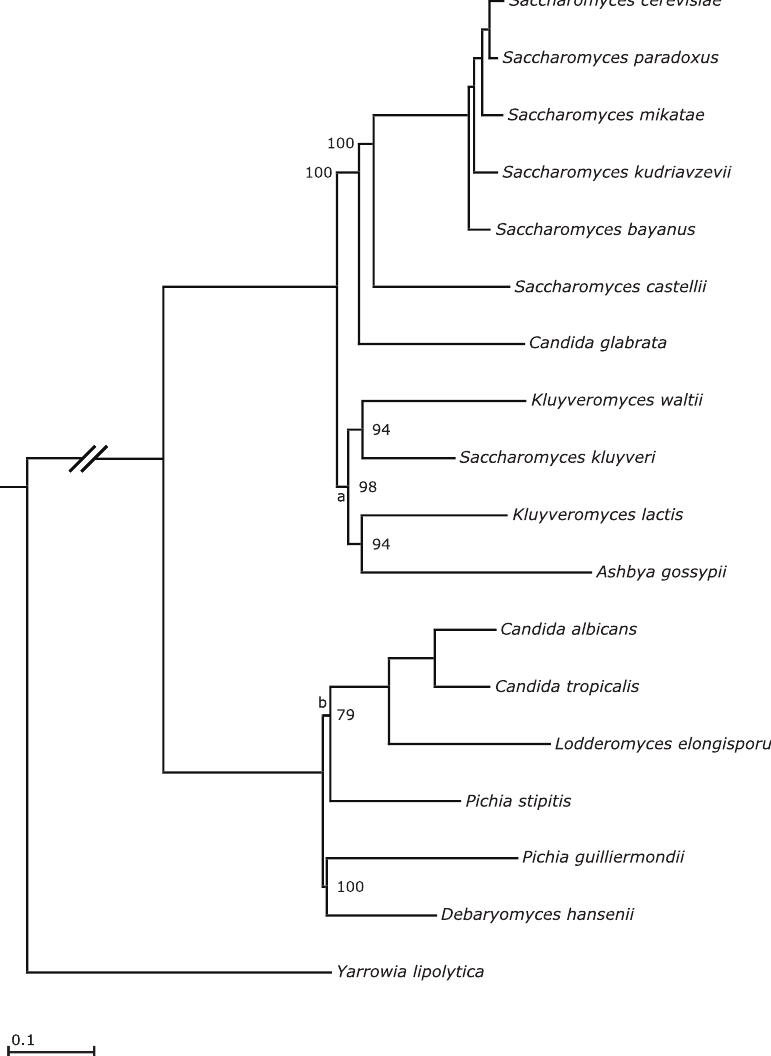
Figure 5. ML tree obtained using the optimal nucleotide and amino acid models of evolution (tree C in Fig. 4). Bootstrap values are from 1000 iterations of RELL resampling and branch lengths, in expected number of substitutions per nucleotide, are calculated as the weighted mean of individual estimates in partitioned analysis of the 343 genes of the nucleotide datasets. The branches marked by lowercase letters were extended for the purpose of visualization.